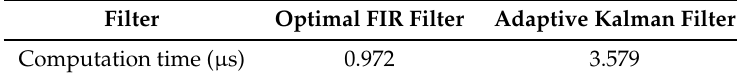
Table 5. The comparison of the average computation time.